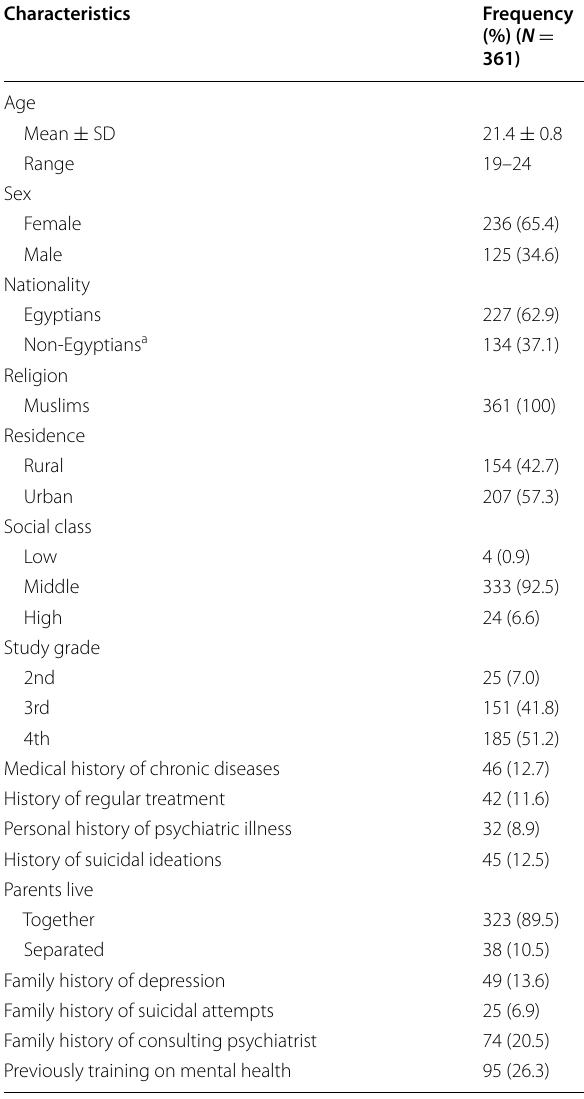
Table 1 Sociodemographic characteristics, medical, mental, and family histories of studied medical